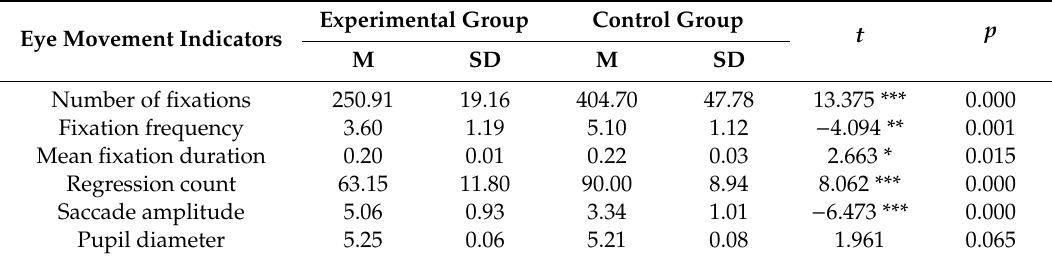
Table 2. The t -test results of eye movement indicators for the two